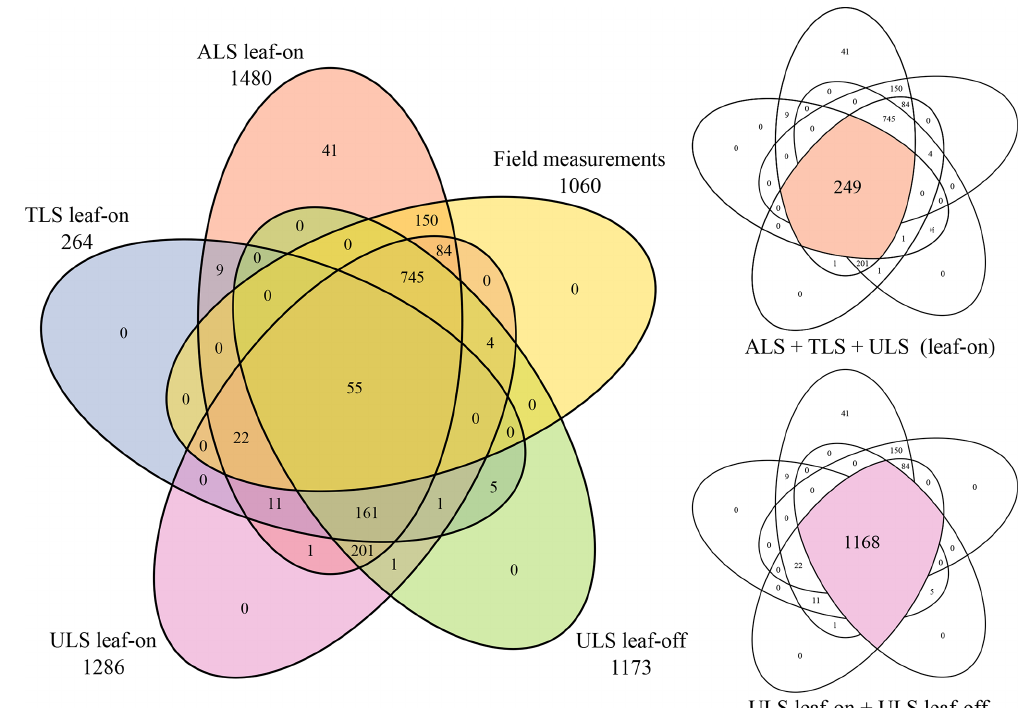
Figure 8. Venn diagrams showing the number of trees covered by the different acquisitions.